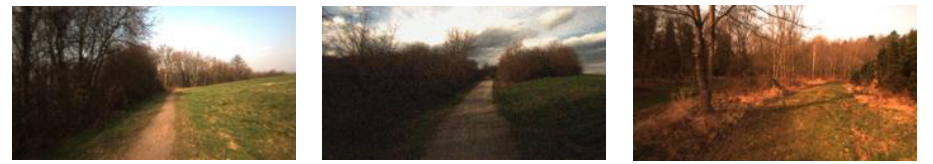
Figure 5. Sample images from Freiburg Forest dataset. Best viewed in color.